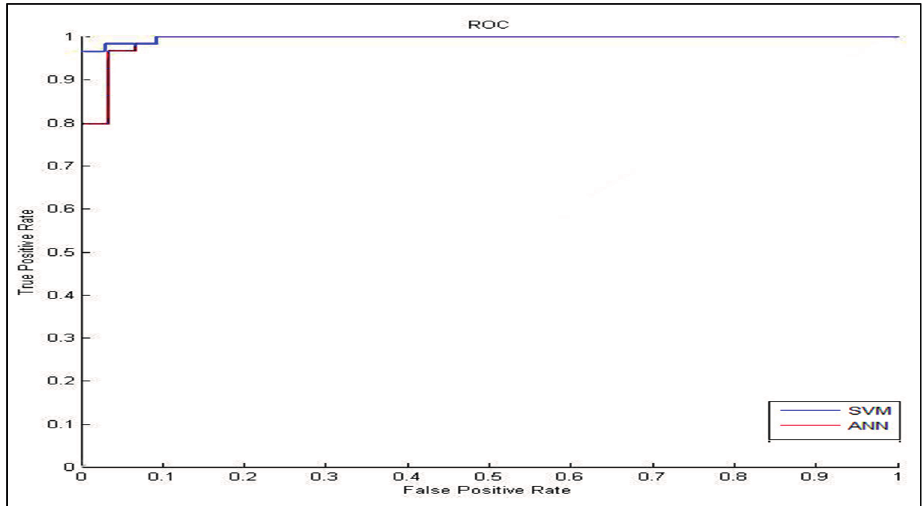
Figure 16. ROC curve obtained using ANN and SVM classifiers.